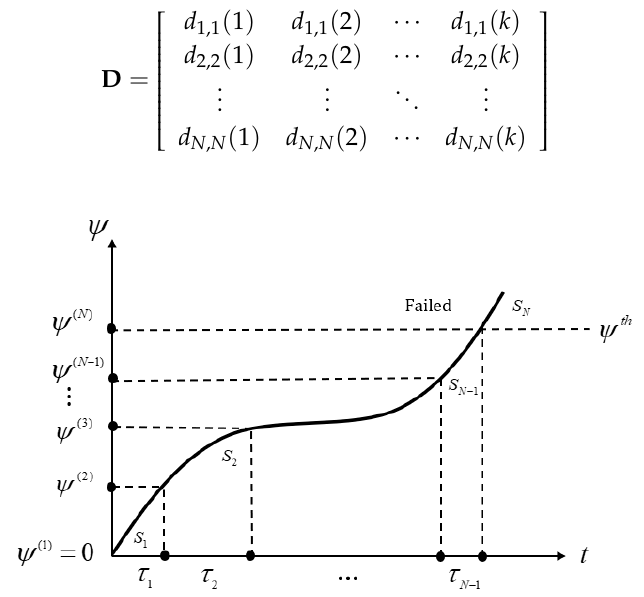
Figure 2. Degrading process of an ETU.